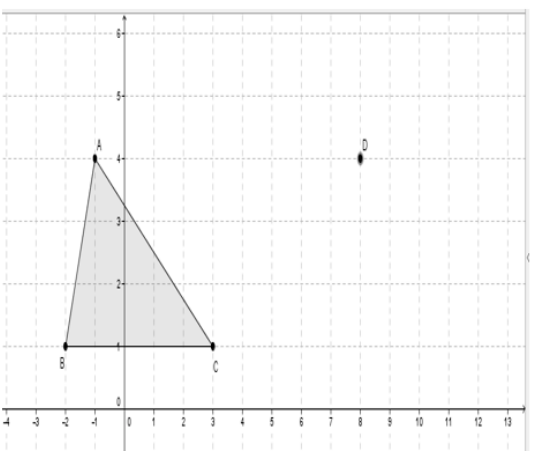
Table 1. Students’ definitions of the congruent triangles, before and after the learning process.